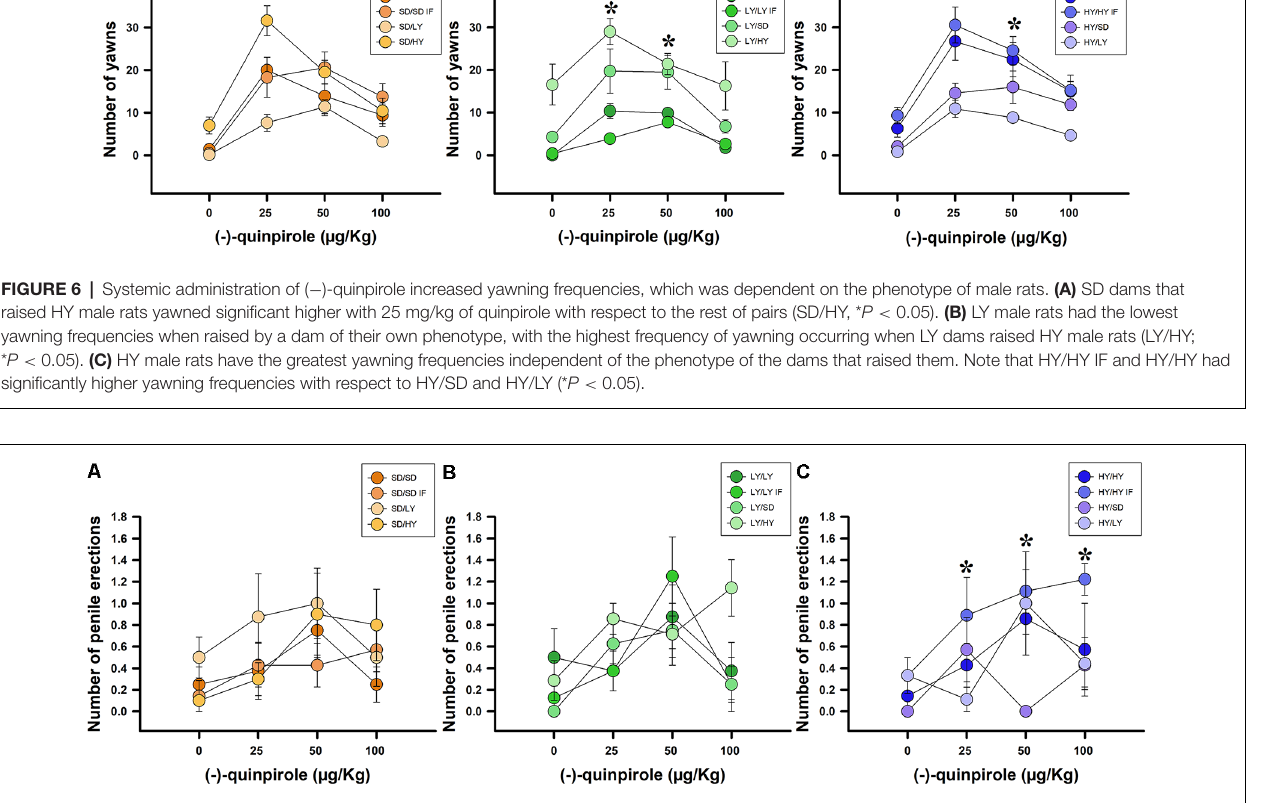
effects were detected, a single ED 50 was estimated at 53.31 µ